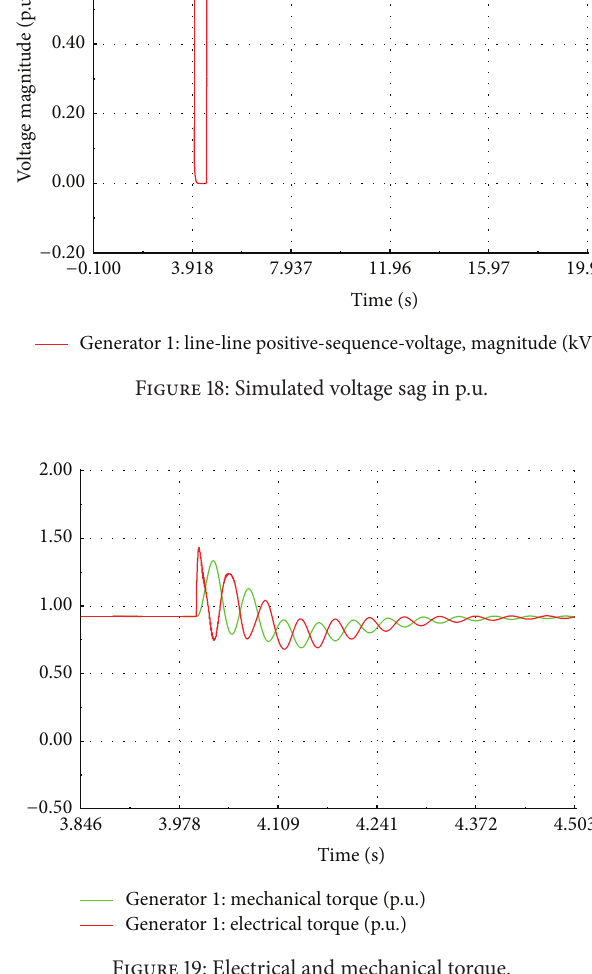
Figure 19: Electrical and mechanical torque.